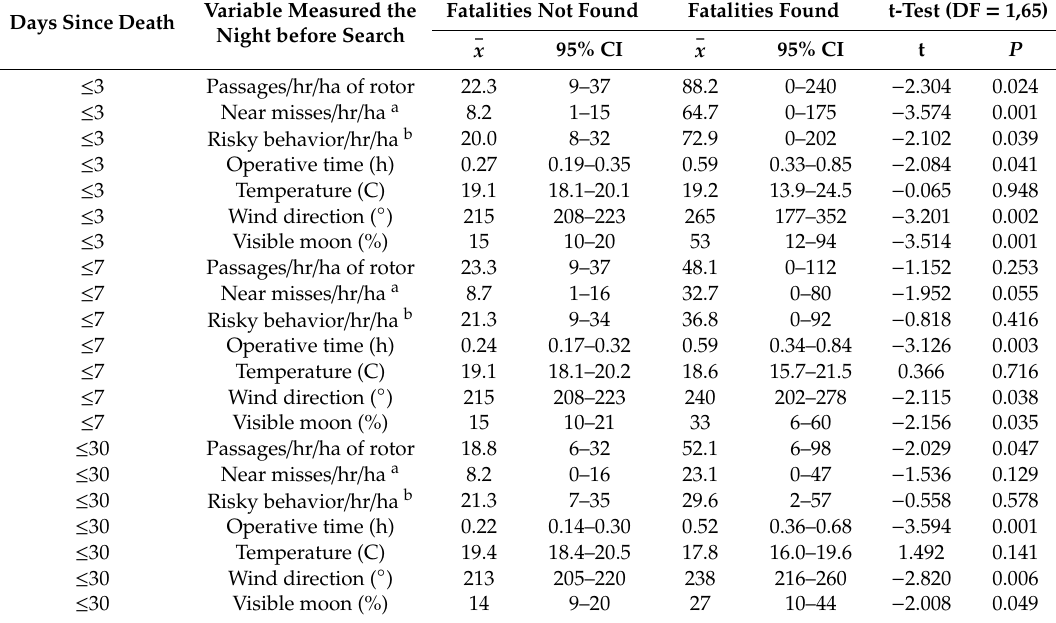
Table 2. Independent sample t-tests to determine whether means of measured variables di ff ered between fatality searches at which bat fatalities were found and not found by scent-detection dogs, and where bats found were estimated to have died within 3 days, 7 days, or 30 days ago,